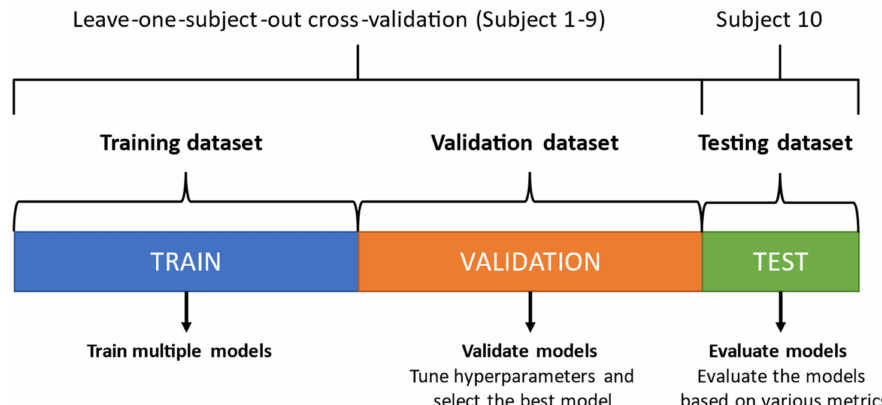
Figure 5. Division of the dataset into a training dataset, validation dataset, and testing